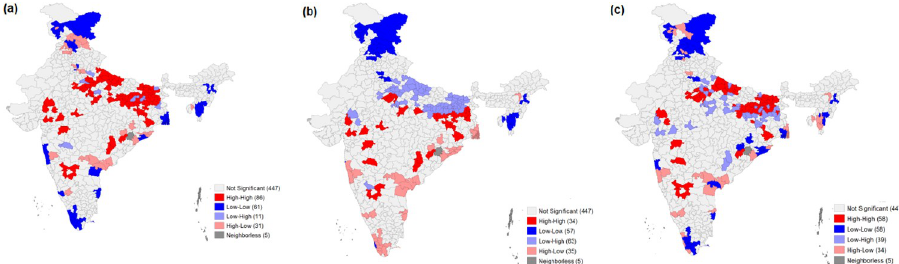
Fig 7. Bivariate LISA cluster maps showing the spatial clustering of underweight with a. Minimum meal frequency (MMF) b. Minimum dietary diversity (MDD) and c. Minimum acceptable diet (MAD) among children aged 6–23 months, India, 2015–16.